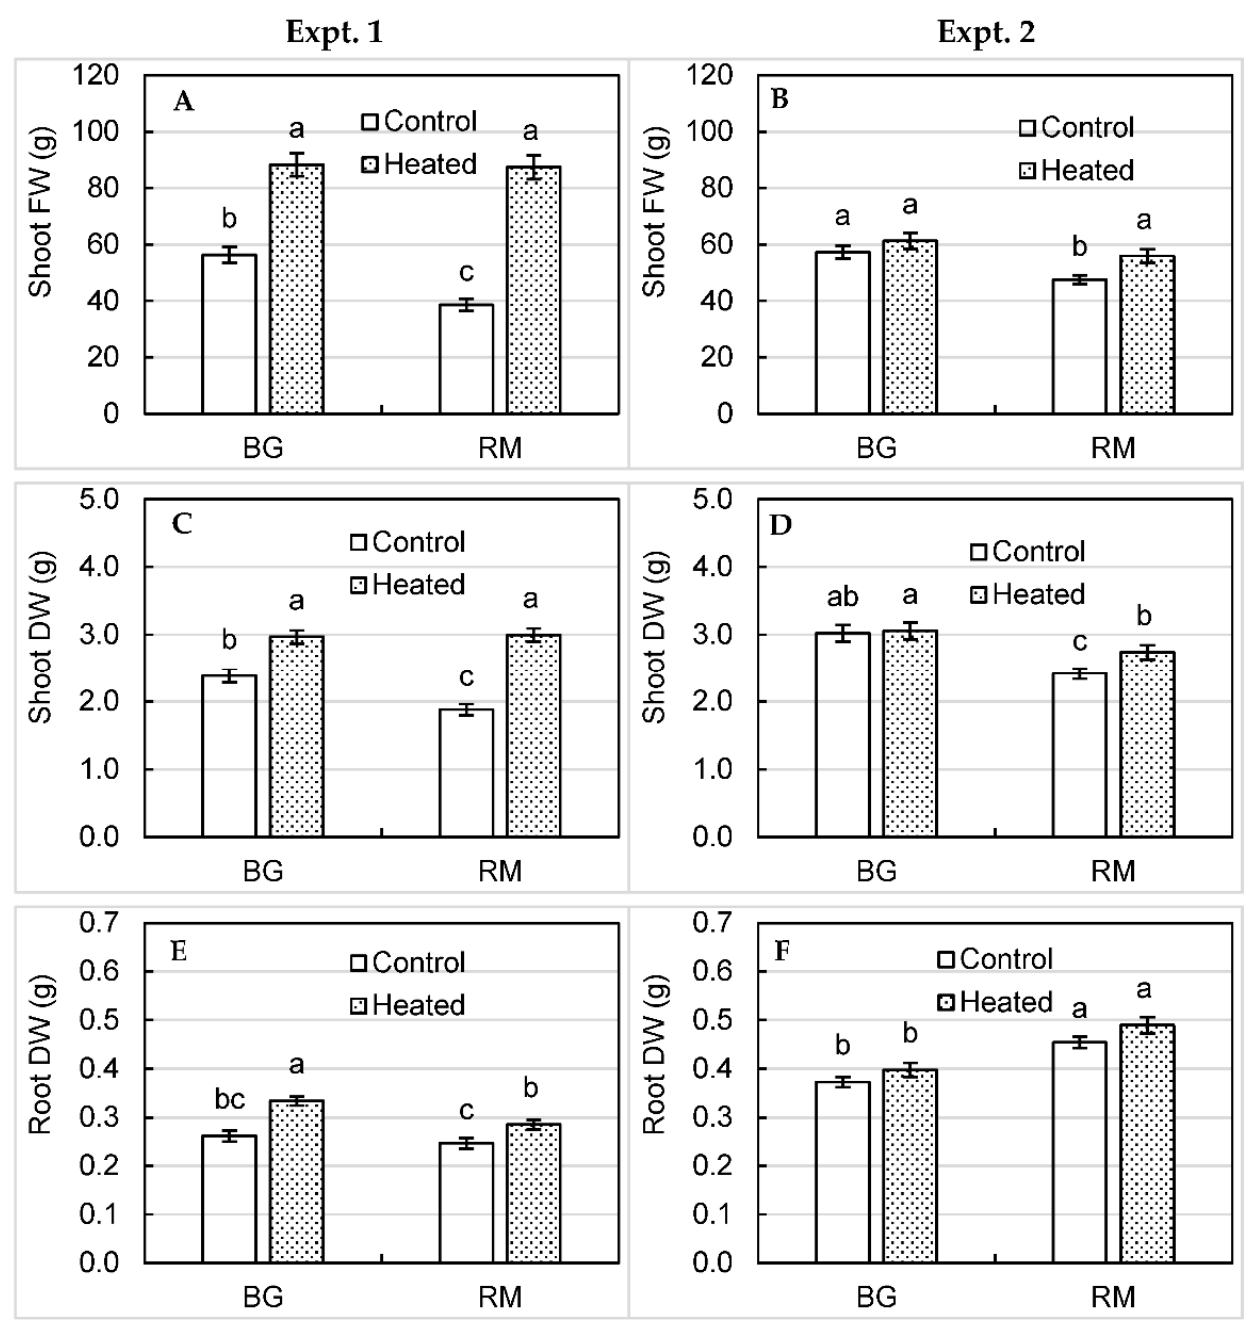
Figure 4. Shoot fresh weight (FW) ( A , B ), dry weight (DW) ( C , D ), and Root dry weight (DW) ( E , F ) of the lettuce varieties ‘Bergam’s Green’ (BG) and ‘Red Mist’ (RM) grown in a deep-water culture hydroponic system with nutrient solution heating or no heating (control). All growth data units are g/plant. Different letters represent significant differences between treatments according to Tukey’s HSD test ( p < 0.05).